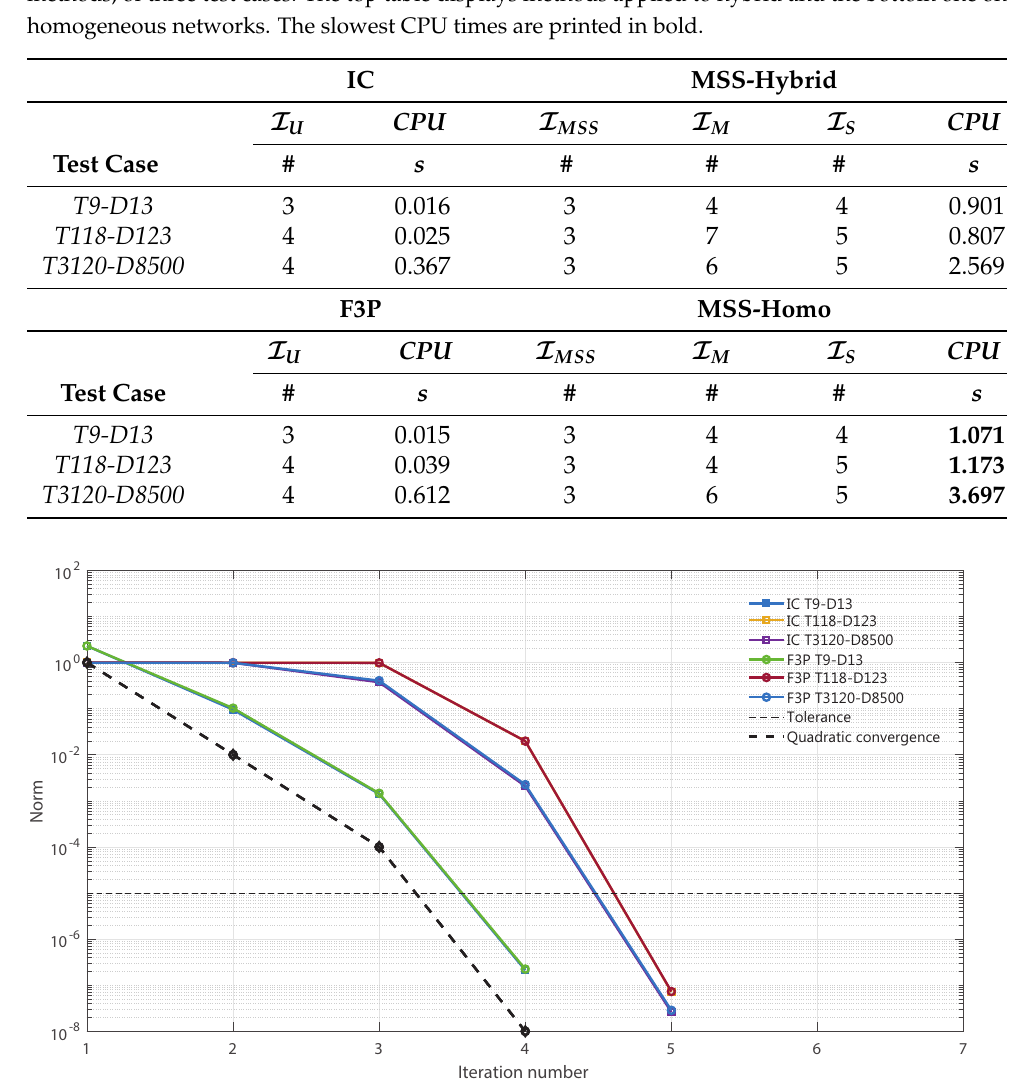
Figure 3. Representation of the relative norms of | F | ∞ , per iteration, of the interconnected and full three-phase methods for three test cases. It is shown that quadratic convergence is preserved (after the first iteration for some of the test cases). The horizontal black dotted line is the tolerance value. Note that the results of the IC methods are not clearly visible because the graphs are below the F3P